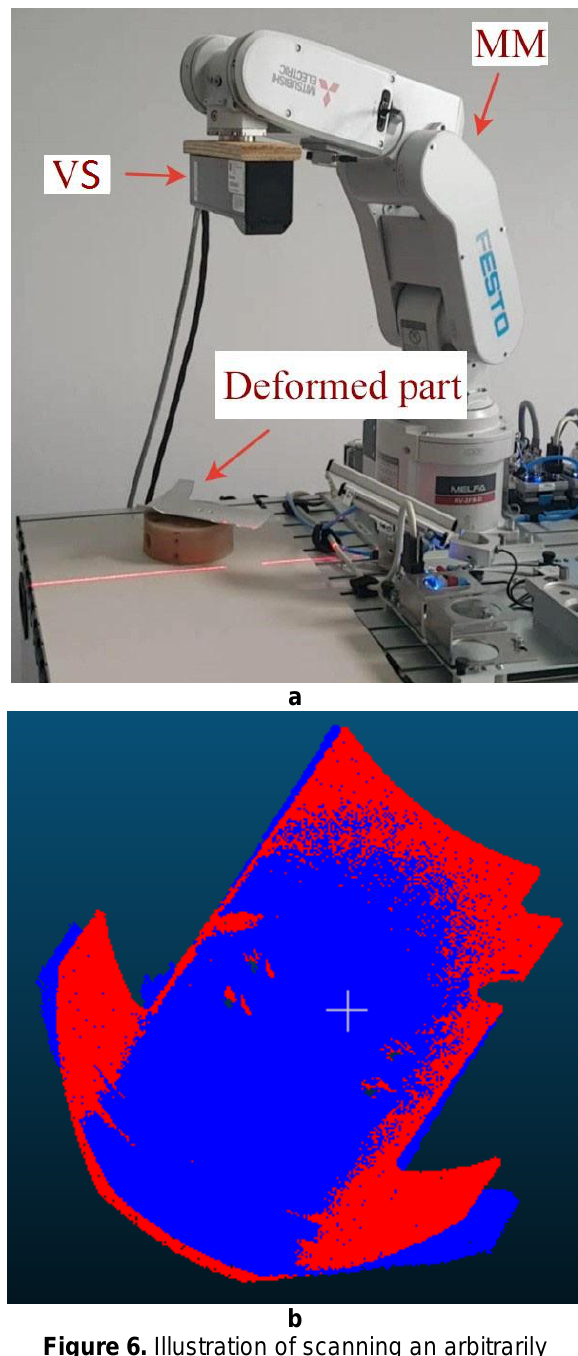
Figure 6. Illustration of scanning an arbitrarily deformed part using VS (a) and obtaining computer models (b) in the form of reference cloud (red cloud) and deformed (blue cloud) part